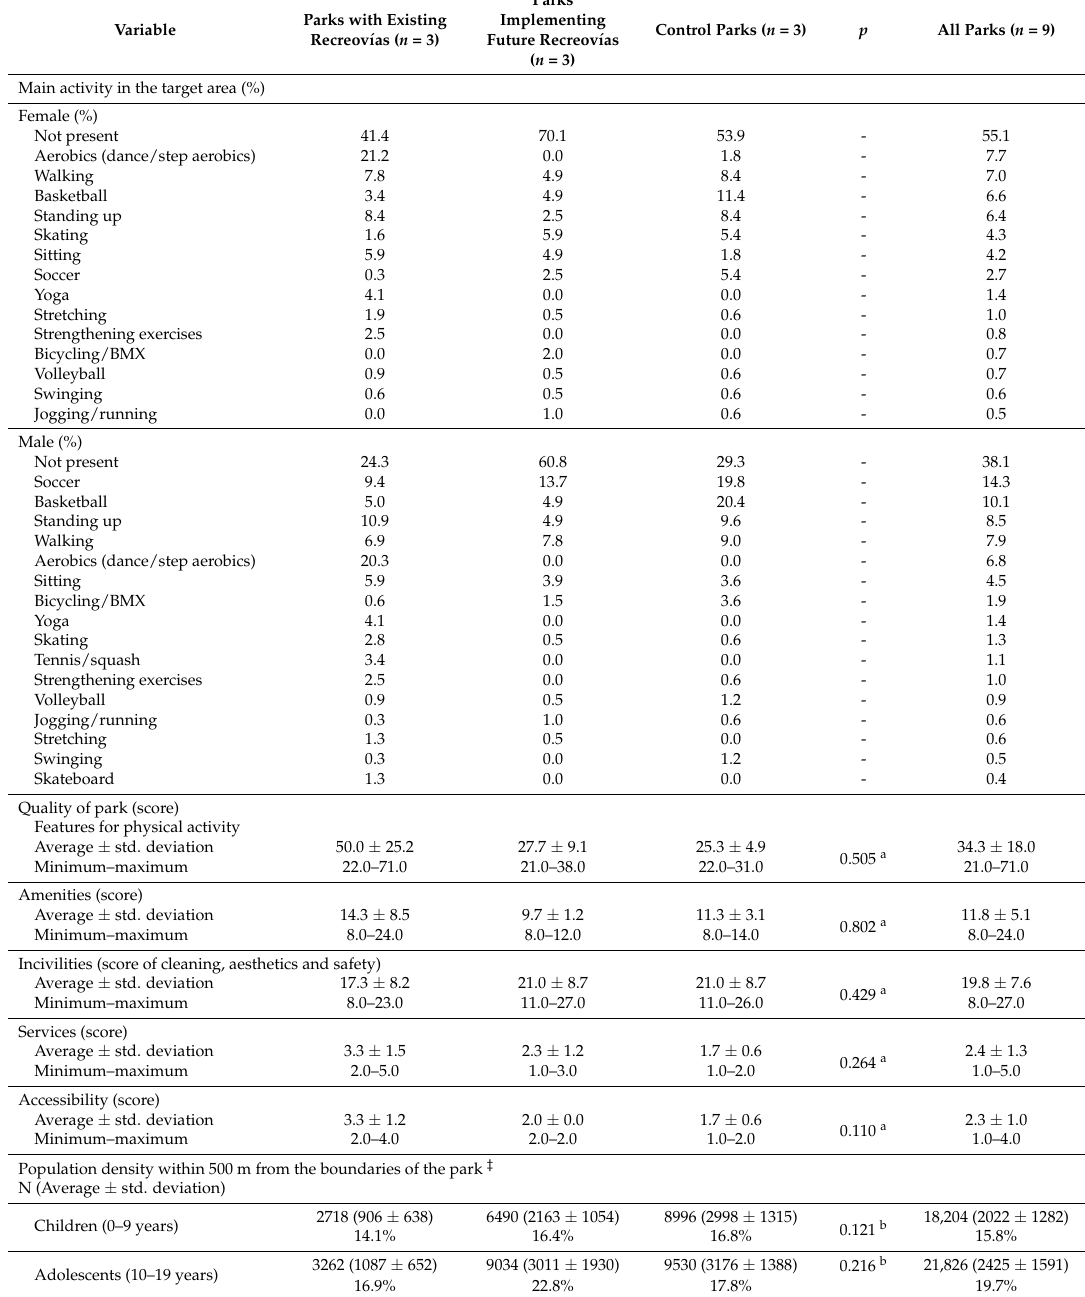
Table 2. Characteristics of main activities observed in the parks by presence of the Recreov í a program in Bogot á , Colombia, 2013. Variable Parks with Existing Recreov í as ( n = 3)